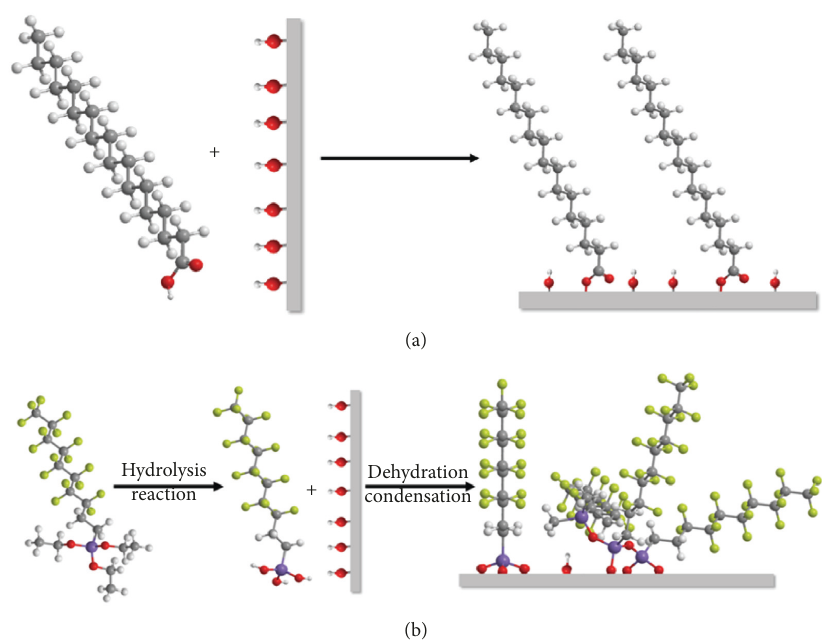
Figure 6: Schematic illustration of the formation of self-assembled (a) STA film layer and (b) FAS film layer onthe deposited nano-Al film